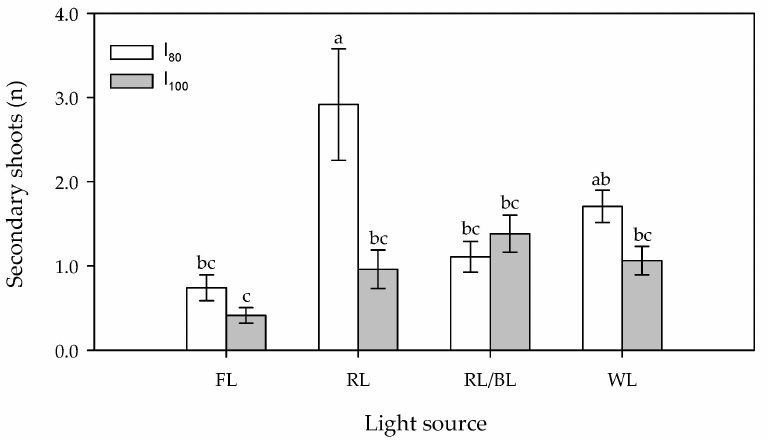
Figure 1. Effect of light source (FL = Fluorescence, RL = predominantly Red, RL/BL = Red/Blue and WL = White light) and light intensity (I 80 and I 100 = 80 and 100 µ mol m − 2 s − 1 , respectively) on in vitro secondary shoot number per plant. Different letters indicate significant differences for p < 0.05, error bars indicate standard error of the means.